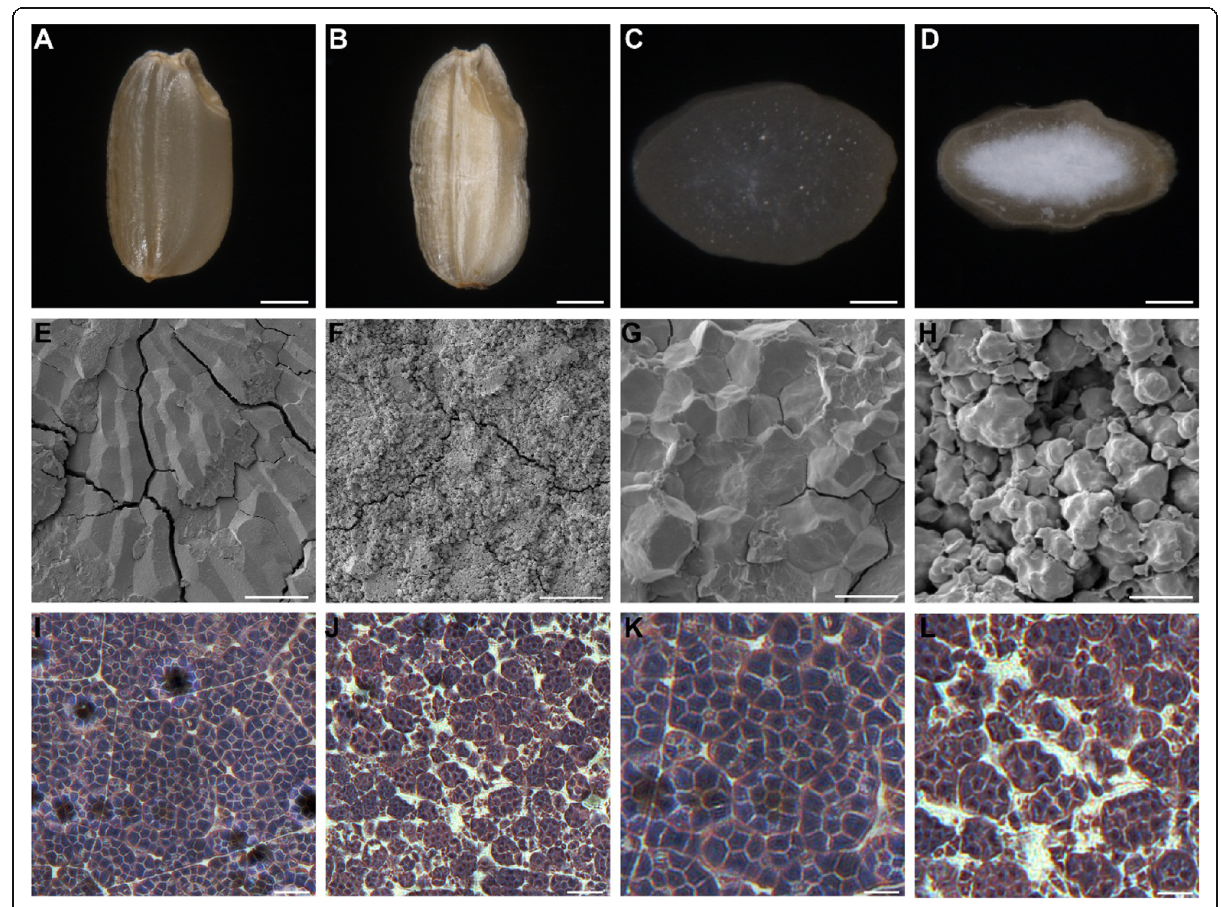
Fig. 1 Phenotypes of mature and developing seeds of the WT and fse5 mutant. a and b Mature WT ( a ) and fse5 ( b ) seeds. Bars, 1 mm. c and d Transverse sections of mature WT ( c ) and fse5 ( d ) seeds. Bars, 0.5 mm. e-h Scanning electron microscopy of transverse sections of mature WT ( e , g ) and fse5 ( f , h ) seeds. Bars, 100 μ m in ( e ) and ( f ); 10 μ m in ( g ) and ( h ). i - l Iodine-stained semithin endosperm sections of wt ( i , k ) and fse5 ( j , l ) seeds at 12 DAF. Bars, 15 μ m in ( i ) and ( j ); 7.5 μ m in ( k ) and ( l